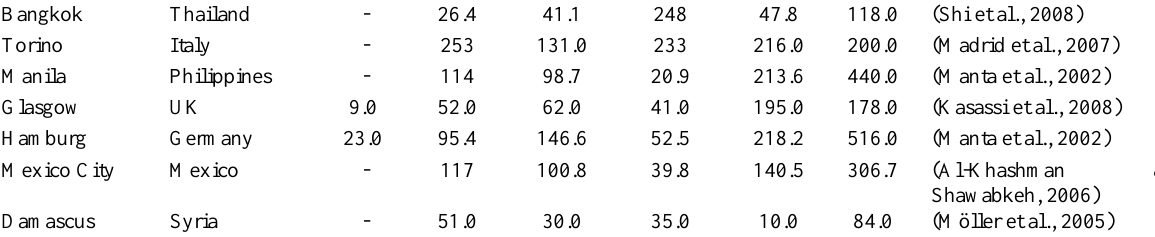
Table 5 . Comparison of the content of heavy metals in international cities